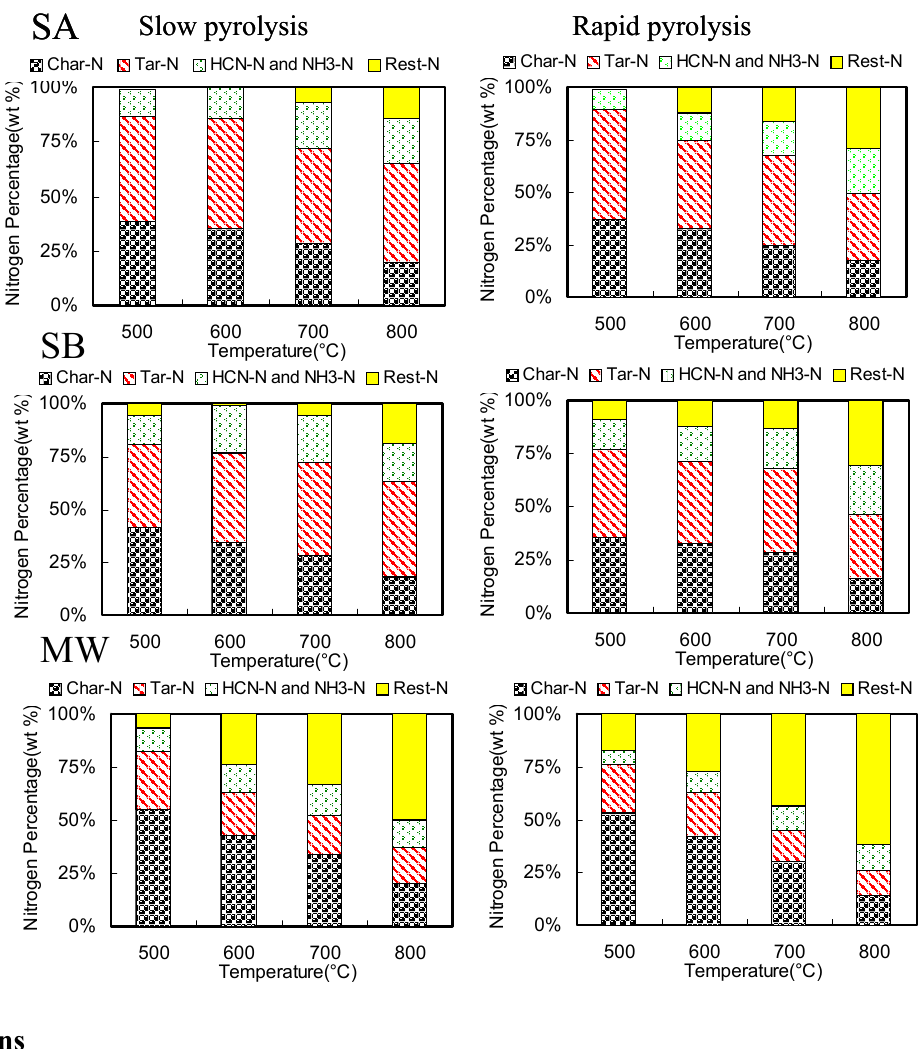
Figure 10. Nitrogen distribution during a series of pyrolysis